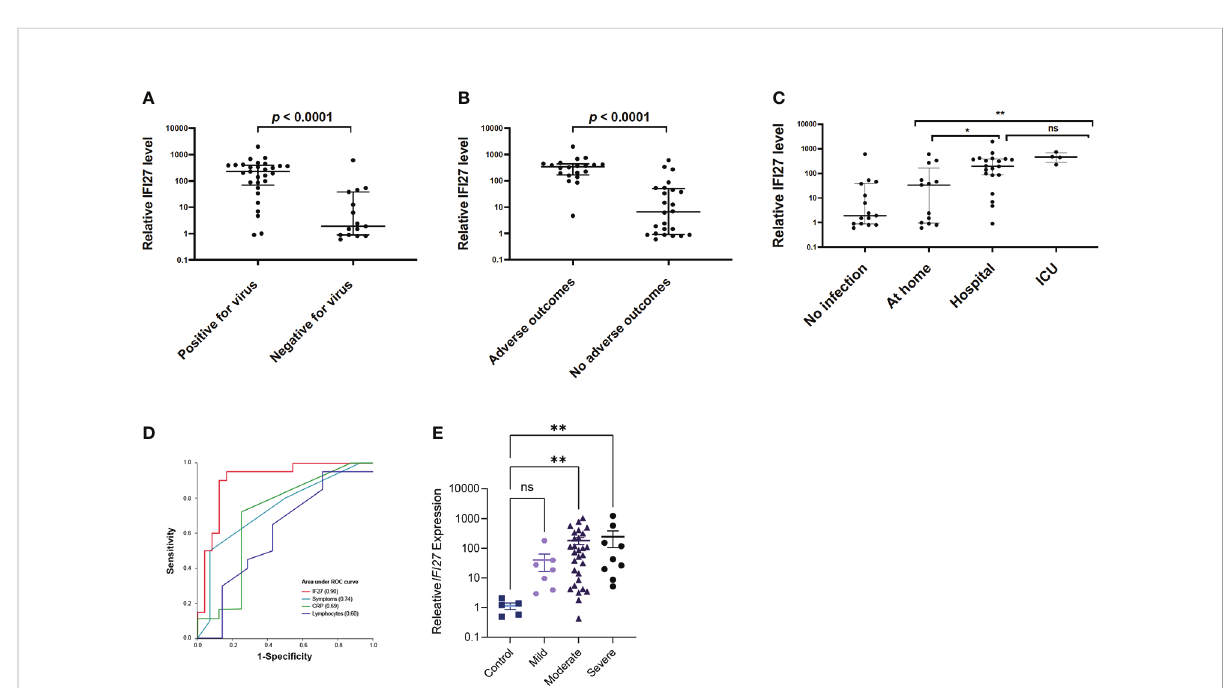
FIGURE 3 Blood IFI27 gene expression in COVID-19 patients (prospective cohorts). (A) Blood IFI27 expression in Cohort 7 (n=44), between those patients with a positive SARS-CoV-2 PCR (labelled as ‘ positive ’ ) (n=29) and those without (labelled as ‘ negative ’ ) (n=15). (B) Blood IFI27 gene expression in Cohort 7 grouped by patients who developed complications (labelled as “ adverse outcomes ” ) (n=20) versus those who did not developed complications (labelled as “ no adverse outcomes ” ) (n=24). (C) Blood IFI27 expression levels grouped by how the patients were managed after infection was diagnosed. A total of 37 patients had adequate follow-up data, including those being managed at home (n=13), admitted to hospital ward (n=20) or admitted to intensive care unit (n=4) ” . (D) Area-under-the-curve of Receiver-Operator-Characteristics curve